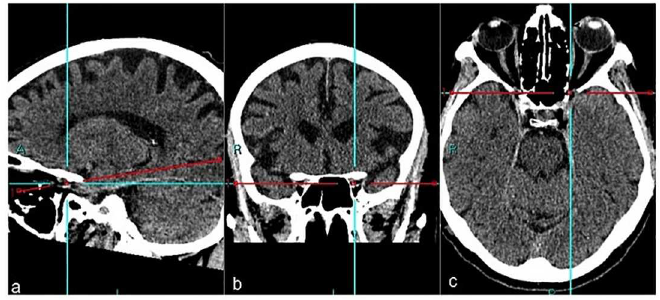
Fig 4. MPR reconstruction in sagittal (a), coronal (b) and axial (c)